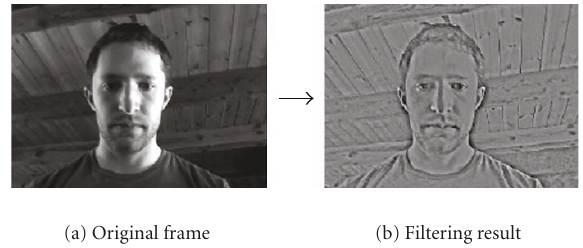
Figure 6: Homomorphic